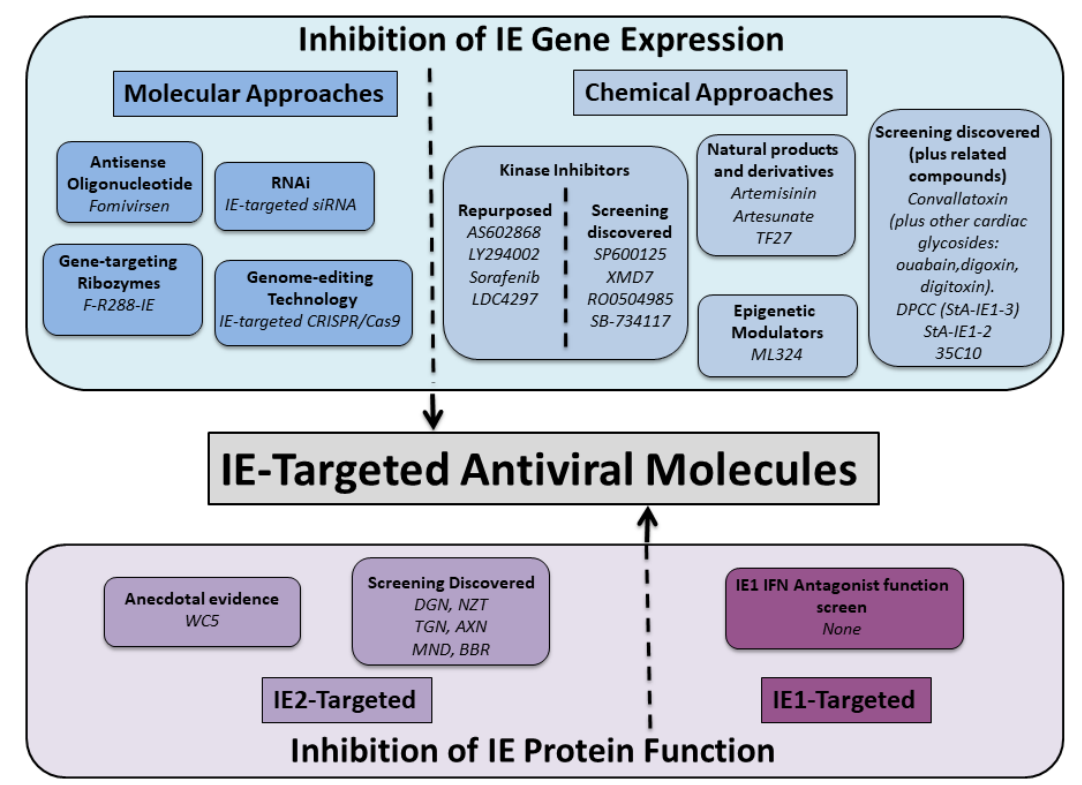
Figure 2. Schematic of molecular and chemical approaches used to target major IE gene expression and IE protein function. Key groups of molecules are listed by category, and examples of molecules within each category given in italics. DGN, deguelin; NZT, nitazoxanide; TGN, thioguanosine; AXN, alexidine dihydrochloride; MND, manidipine dihydrochloride.